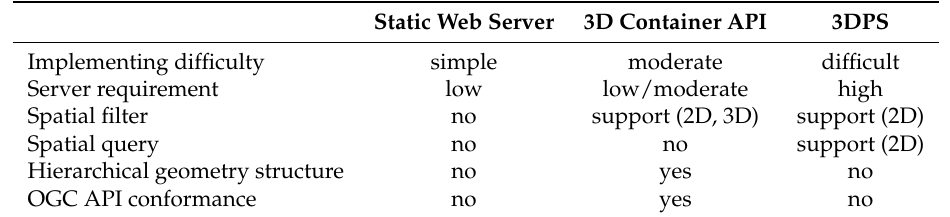
Table 2. Comparison of different approaches for the 3D data management in the 3D Geodata-Portal. Static Web Server 3D Container API 3DPS